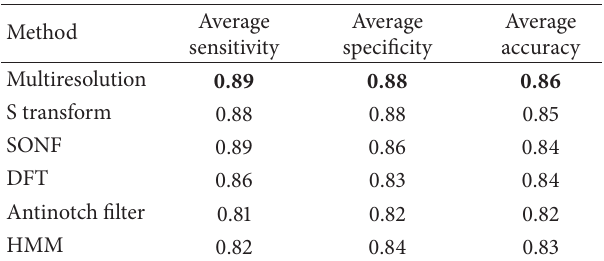
Table 6: Evaluation metrics of 100 genes from HMR 195